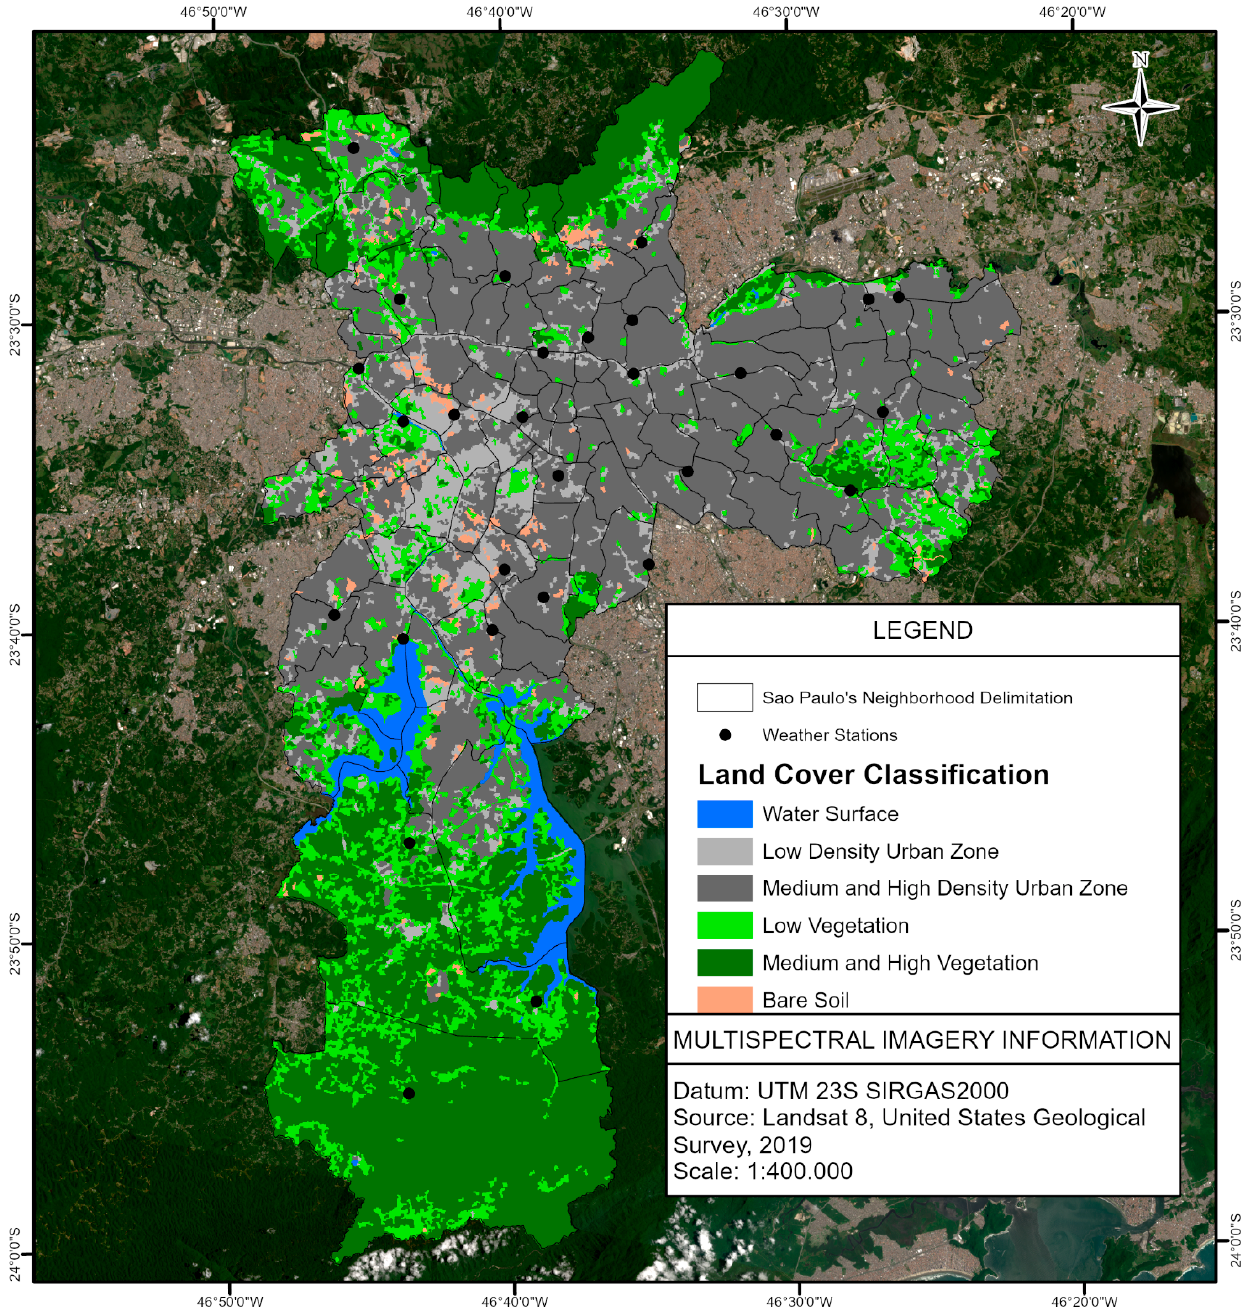
Figure 6. LULC classification of São Paulo City using a spectral angle mapper algorithm. Source: Landsat 8, United States Geological Survey. Elaborated by authors (2021).